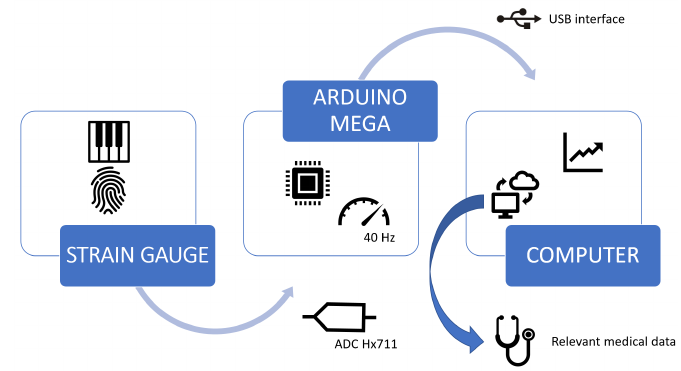
Figure 3. Rehapiano device data